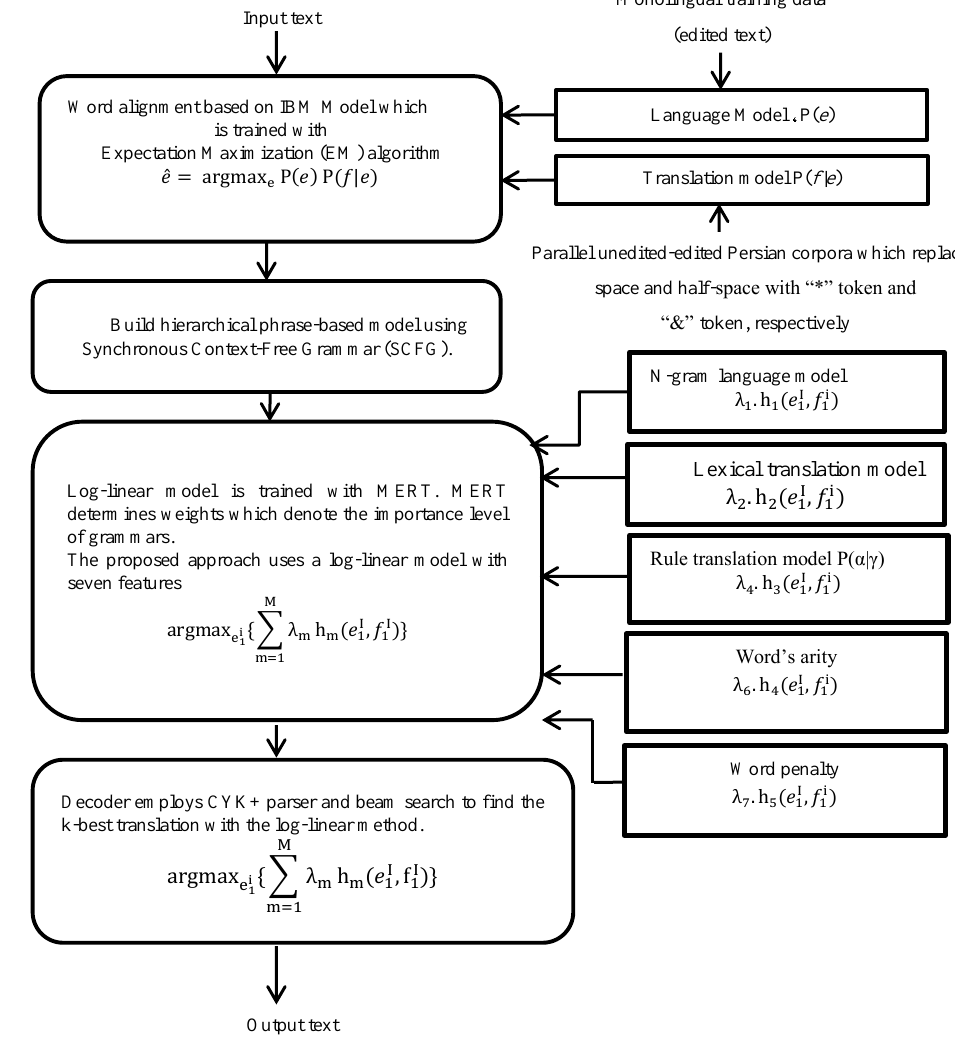
Figure 2. Graphical representation of the proposed